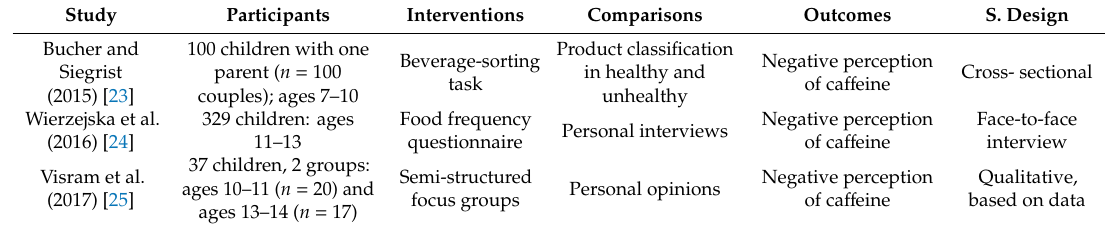
Table 3. Analysis of studies on ca ff eine intake perception, according to the PICOS 1